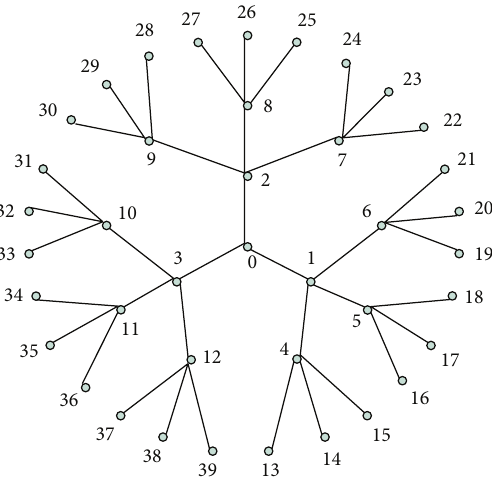
Figure 1: The labeling of vertices for the 3-branching rooted tree.